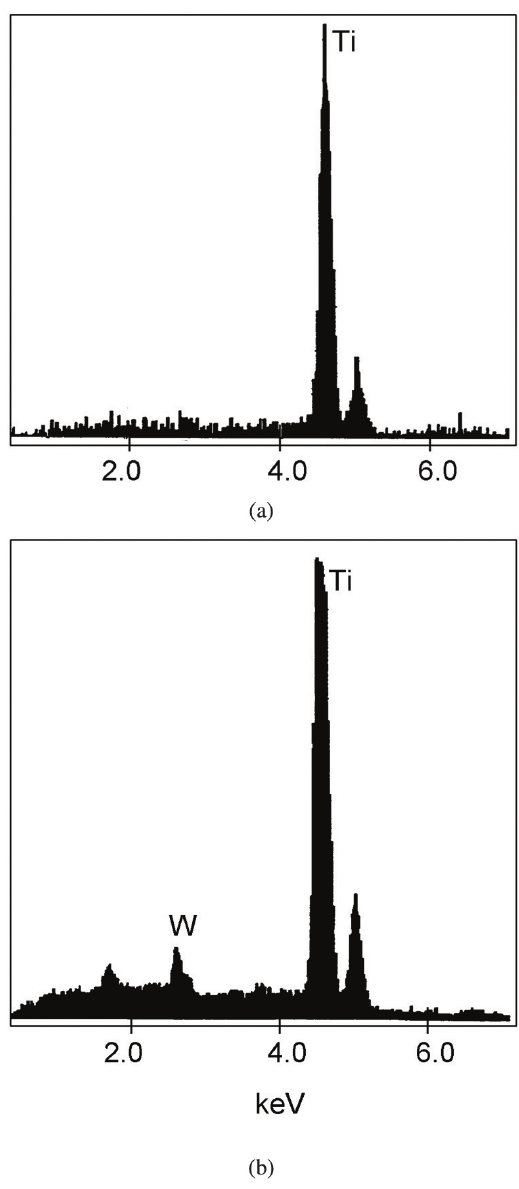
Figure 3. EDS spectra for the generated nanogranules by a) nitrogen and b) oxygen.